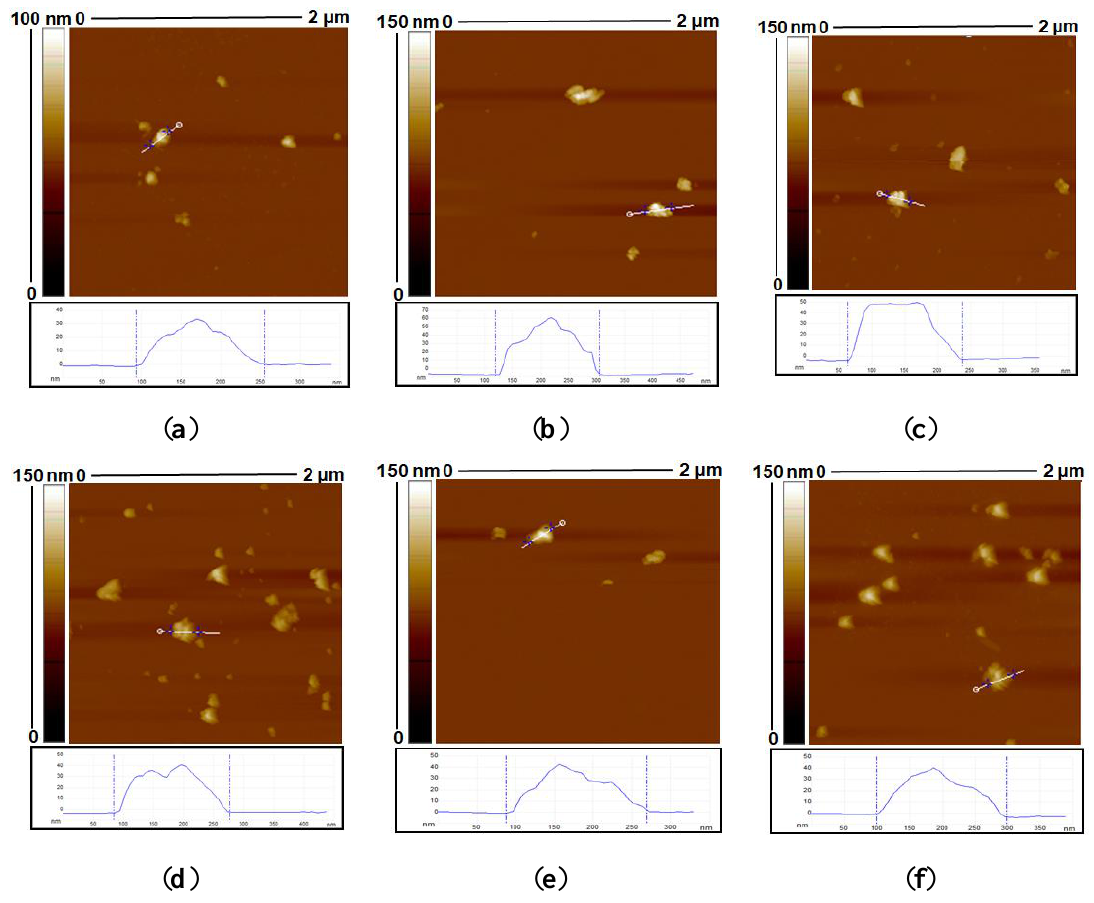
Figure 3. AFM images of Curcumin (CUR)-loaded MAPs ( a ) and CUR loaded MACPs (CMACPs) with the layer number of 1 ( b ), 4 ( c ), 5 ( d ), 8 ( e ) and 9 ( f